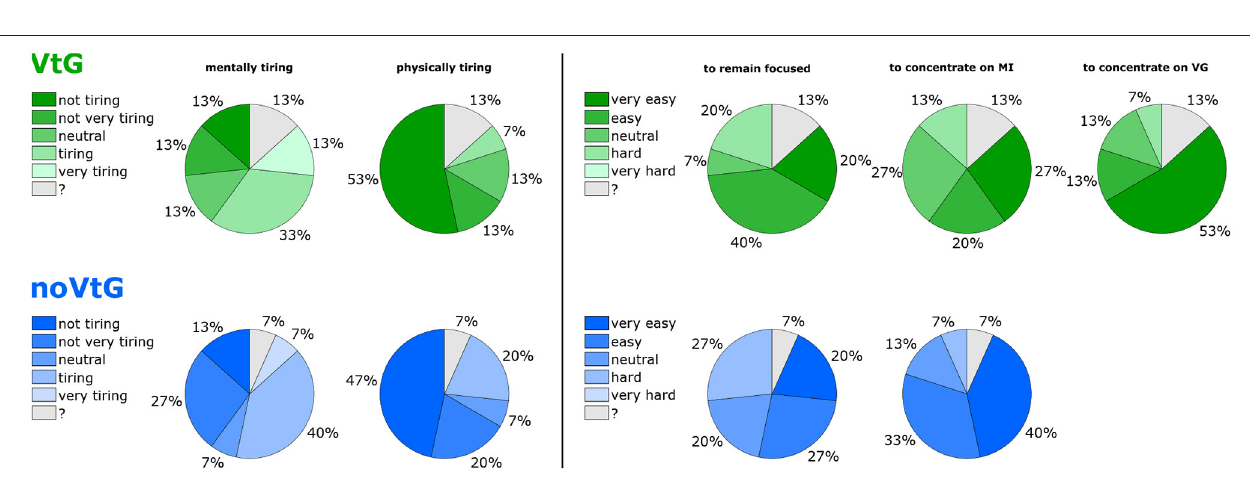
FIGURE 8 | Overview of subjective ratings on the questionnaire. The (top) row (green colors) refers to condition VtG, the (bottom) row (blue colors) to condition noVtG. Darker colors correspond to a lower rated effort (e.g., “not at all tiring,” or “very easy to concentrate.” The gray portions identify invalid/missing answers.